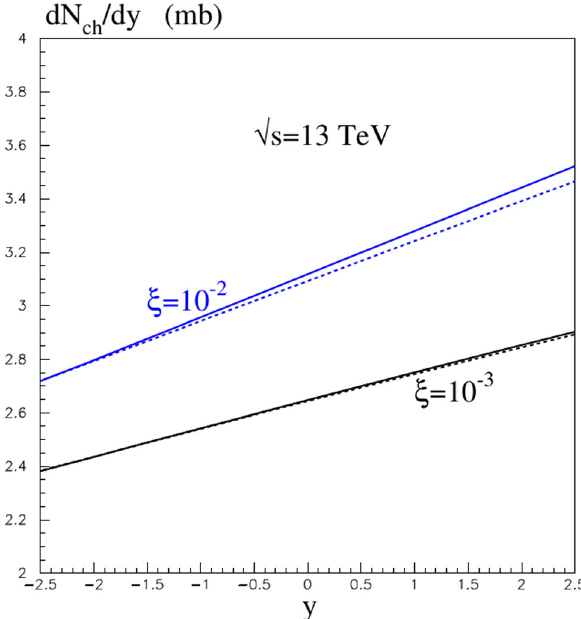
Fig. 9 Therapiditydependenceofthechargedmultiplicityobservedin thecentraldetectorforSDeventswith ξ = 0 . 01(blue)and0.001(black) √ s = 13 TeV. The dashed curves correspond to the pure Pomeron- at induced cross section without the secondary Reggeon contribution